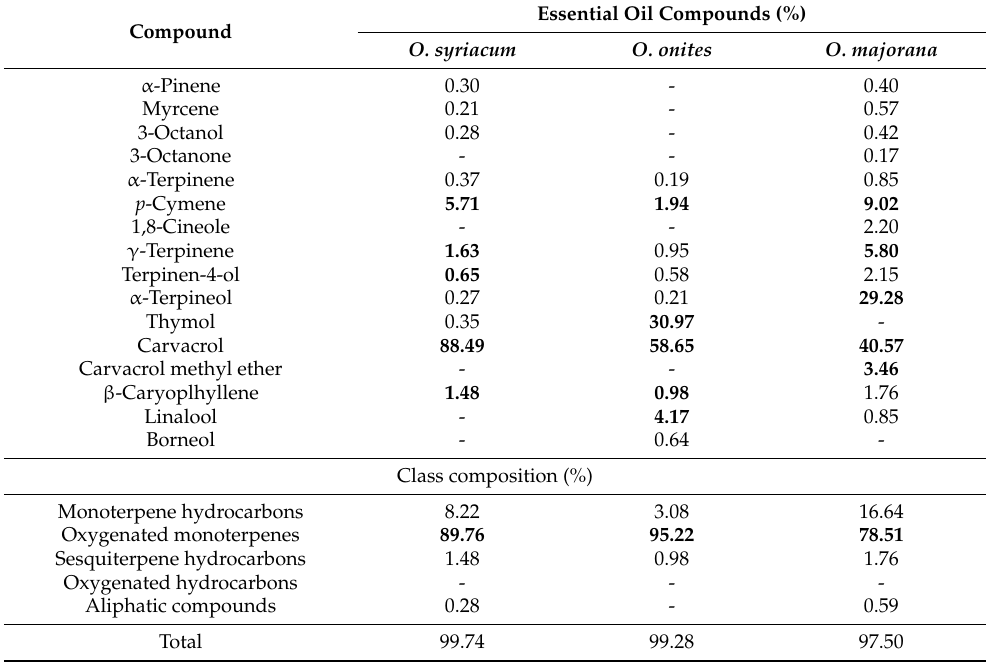
Table 2. Chemical compositions of essential